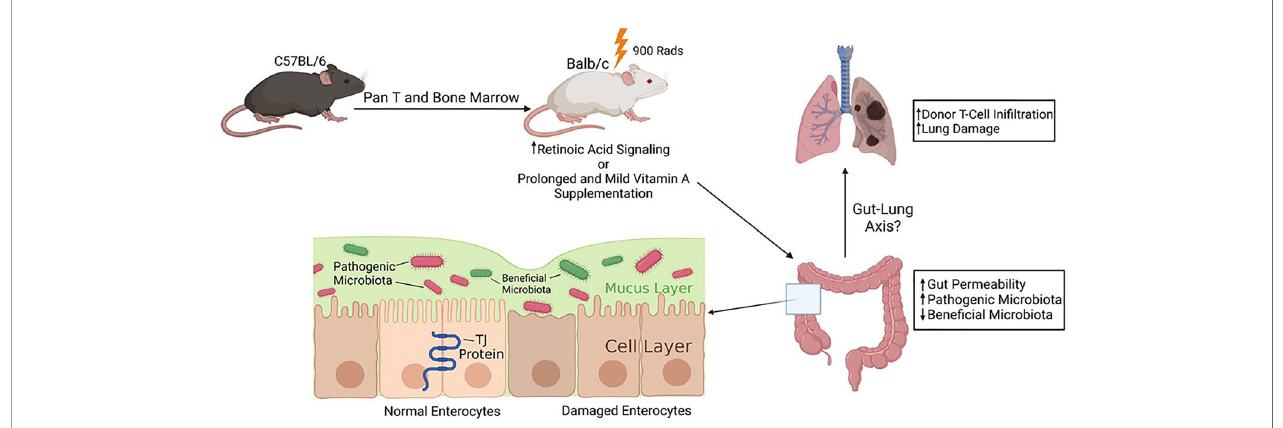
FIGURE 7 | Schematic summary of the study. Increased retinoic acid signaling or prolong and mild vitamin A supplementation may negatively impact intestinal barrier function during GVHD. Mild vitamin A supplementation is associated with increased lung damage and more profound gut dysbiosis in recipient mice. Micronutrients such as vitamin A could modulate complications of allogeneic HSCT, which may be mediated by shaping gut microbiota. Created with